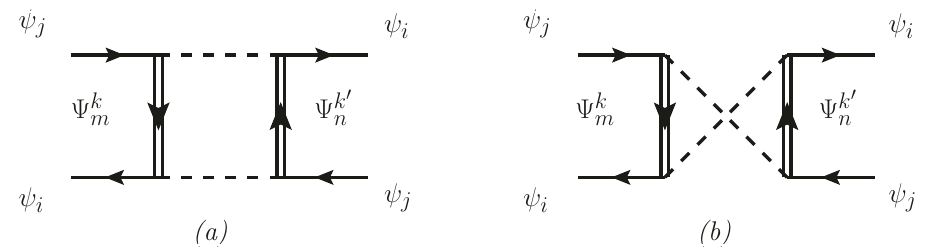
Figure 11 . One loop diagrams contributing to neutral-meson mixing induced at Higgs-mediated interactions (dashed lines) with the gears (double